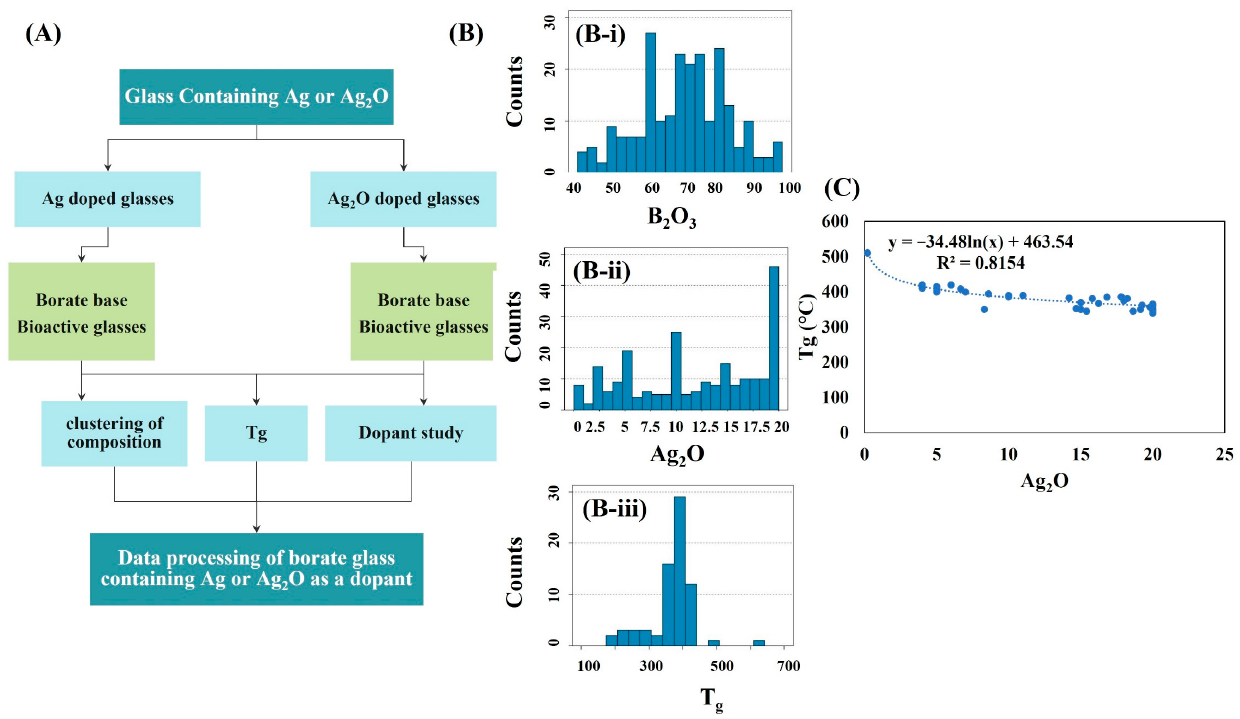
Figure 3. ( A – C ) The adapted data from the Sci-glass database, including decision tree ( A ), frequency distribution histogram of B 2 O 3 ( B-i ), Ag 2 O ( B-ii ), and T g ( B-iii ) ( B ), and the correlation of T g (°C) (y) with the concentration of Ag 2 O (mol%) ( C ).